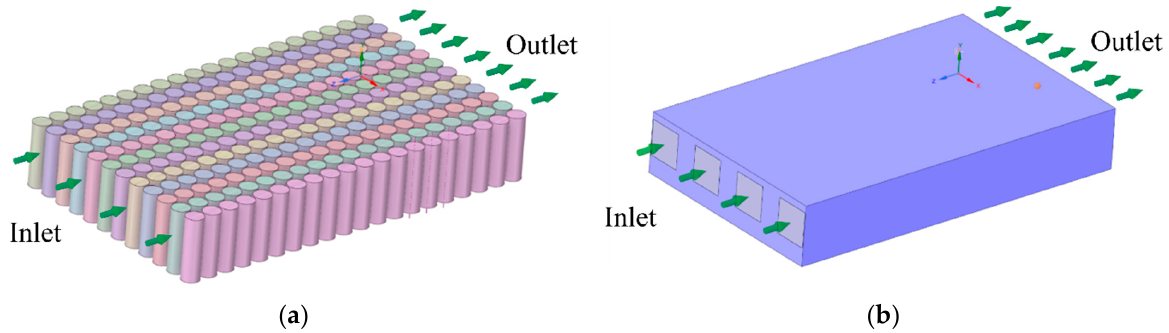
Figure 2. Example of LBM model ( a ) battery cells configuration ( b ) battery pack for 4 inlets.